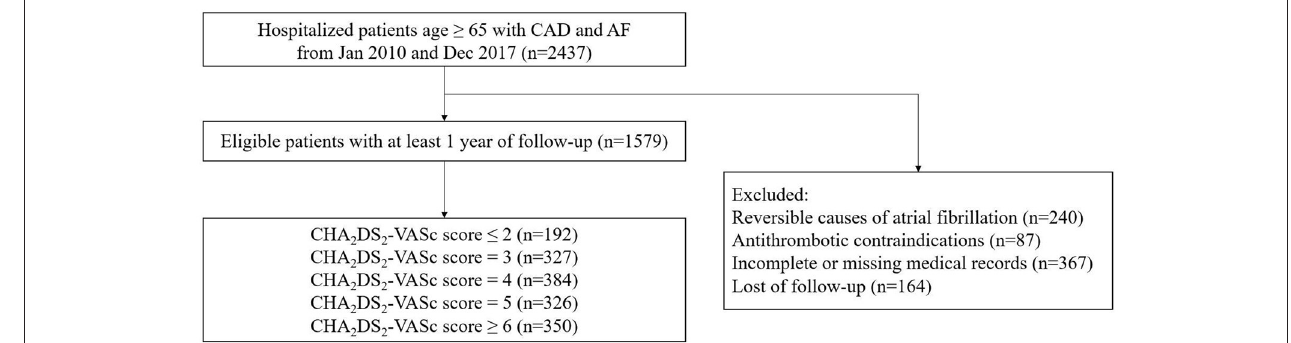
FIGURE 1 | Flow diagram of the study.